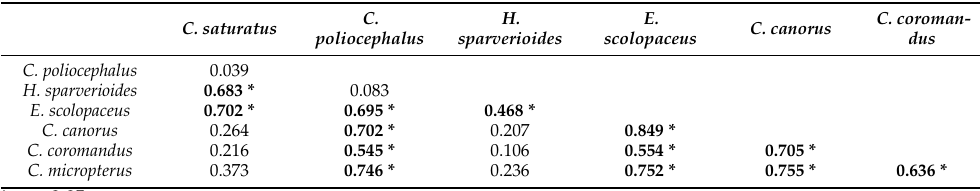
Table 9. The values of the petraitis index showing the degree of seasonal distribution overlap among the seven species in eastern China. Bold digits represent those groups that have high overlap in seasonal distributional